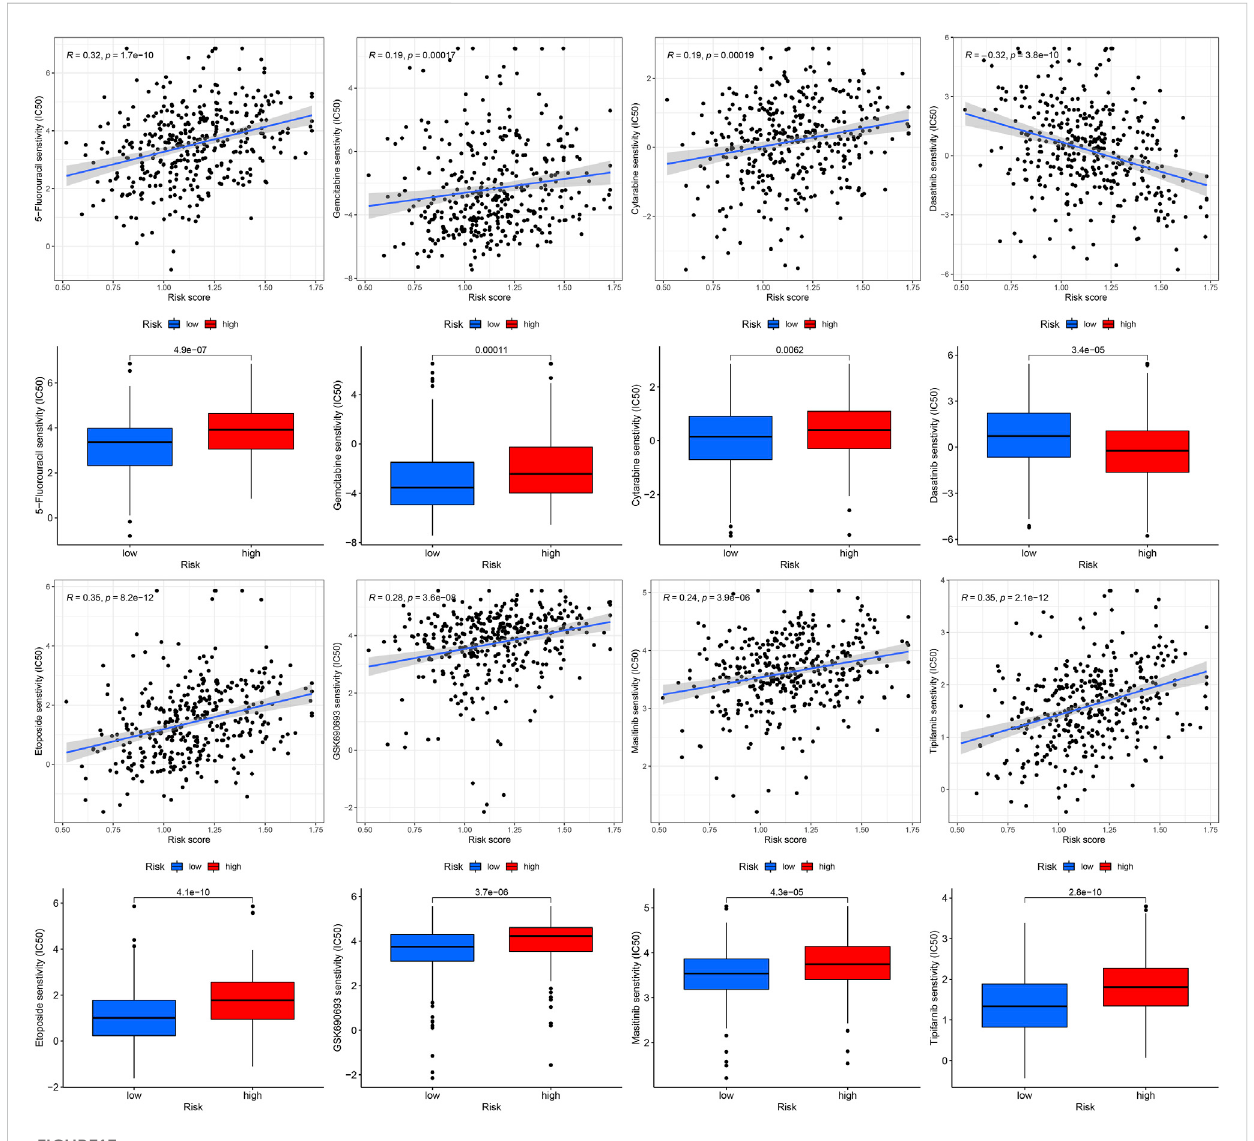
FIGURE13 Drug sensitivity of diverse agent in different risk